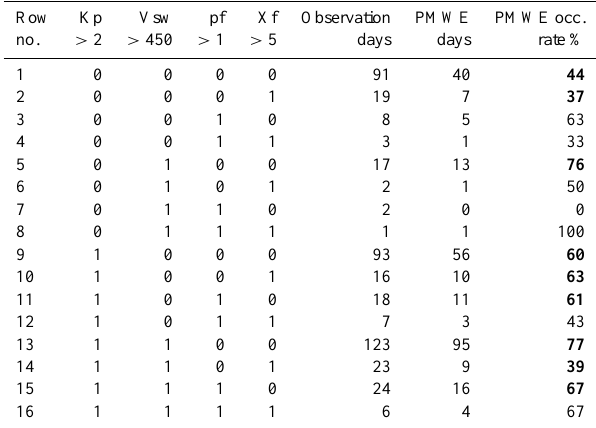
Table 1. Distribution of observation days and days with PMWE detection as a function of the disturbance level each day, as repre- sented by Kp index, solar wind speed (Vsw), solar proton flux (pf) and solar X-ray flux (Xf). Each day is categorized into 1 of 16 possi- ble states according to whether the threshold value for each parame- ter is exceeded at some time during the day. Thresholds are Kp > 2, and Xf > 5 × 10 − 7 Wm − 2 (for 0.5–4.0Å X-rays, only daytime con- sidered). Ones in columns 2–5 indicate that the threshold for the corresponding parameter was exceeded. Column 6 shows the num- ber of days in each category when observations were made, and col- umn 7 shows the number of those days when PWME were detected. PMWE occurrence rates in the final column are the number of days with PWME divided by the number of observation days on each row. These are shown in bold type when the number of observation days is more than 10.